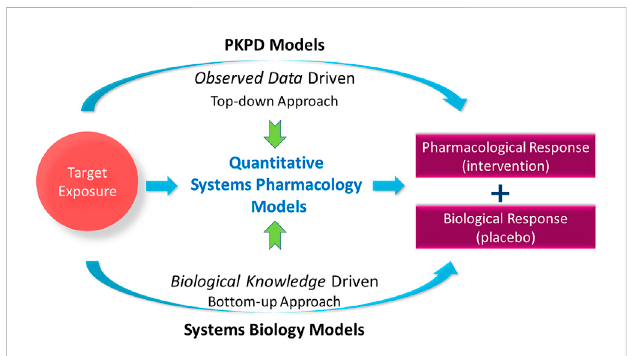
FIGURE 1 Quantitative systems pharmacology models balance the models to predict the pharmacological response via observed data-driven pharmacokinetic-pharmacodynamic (PKPD) models and biological knowledge-driven systems biology